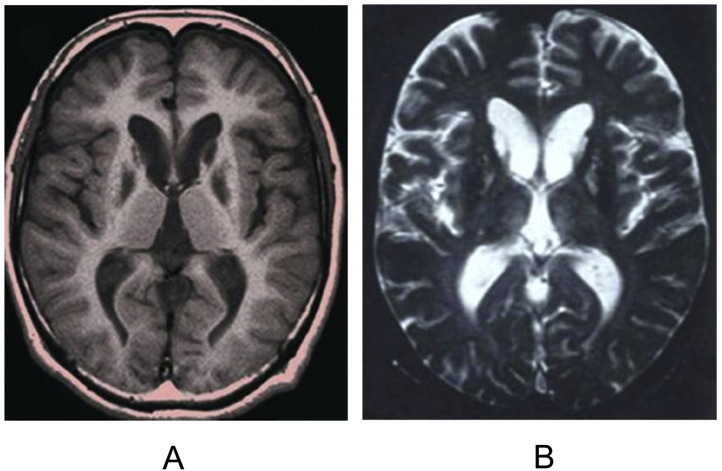
Brain MRI in Neuroferritinopathy. Brain MR images of a Japanese man carrying the FTL1 c469_484dup mutation. Axial section at the level of the basal ganglia in the patient at 35 years of age. A A T1-weighted image (TR 400 msec/ TE 14 msec) shows symmetrical hypointense signals in the head of the caudate nucleus and globus pallidus. B A T2-weighted image (TR 800 msec/TE 30 msec) shows hypointense changes in the lenticular nucleus. Hyperintense signals can be observed in the putamen and the head of the caudate nucleus. Reproduced from Ohta E, Takiyama Y. MRI findings in neuroferritinopathy. Neurol Res Int. 2012;2012:197438.